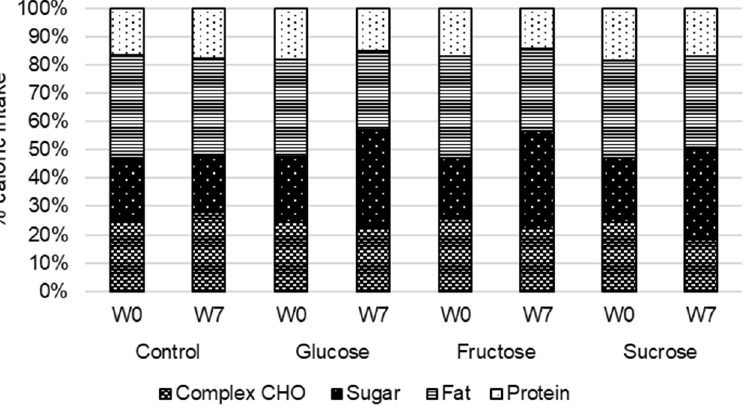
Figure 2. Macronutrient composition of the diet at baseline (W0) and at week 7 (W7) of the